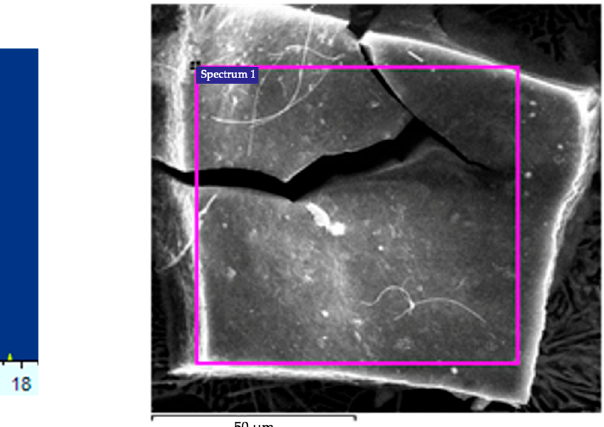
Figure 9. Spectrum of elements and SEM image of sediment (sludge). Table 7. Chemical composition of the sediment of the residual fuel